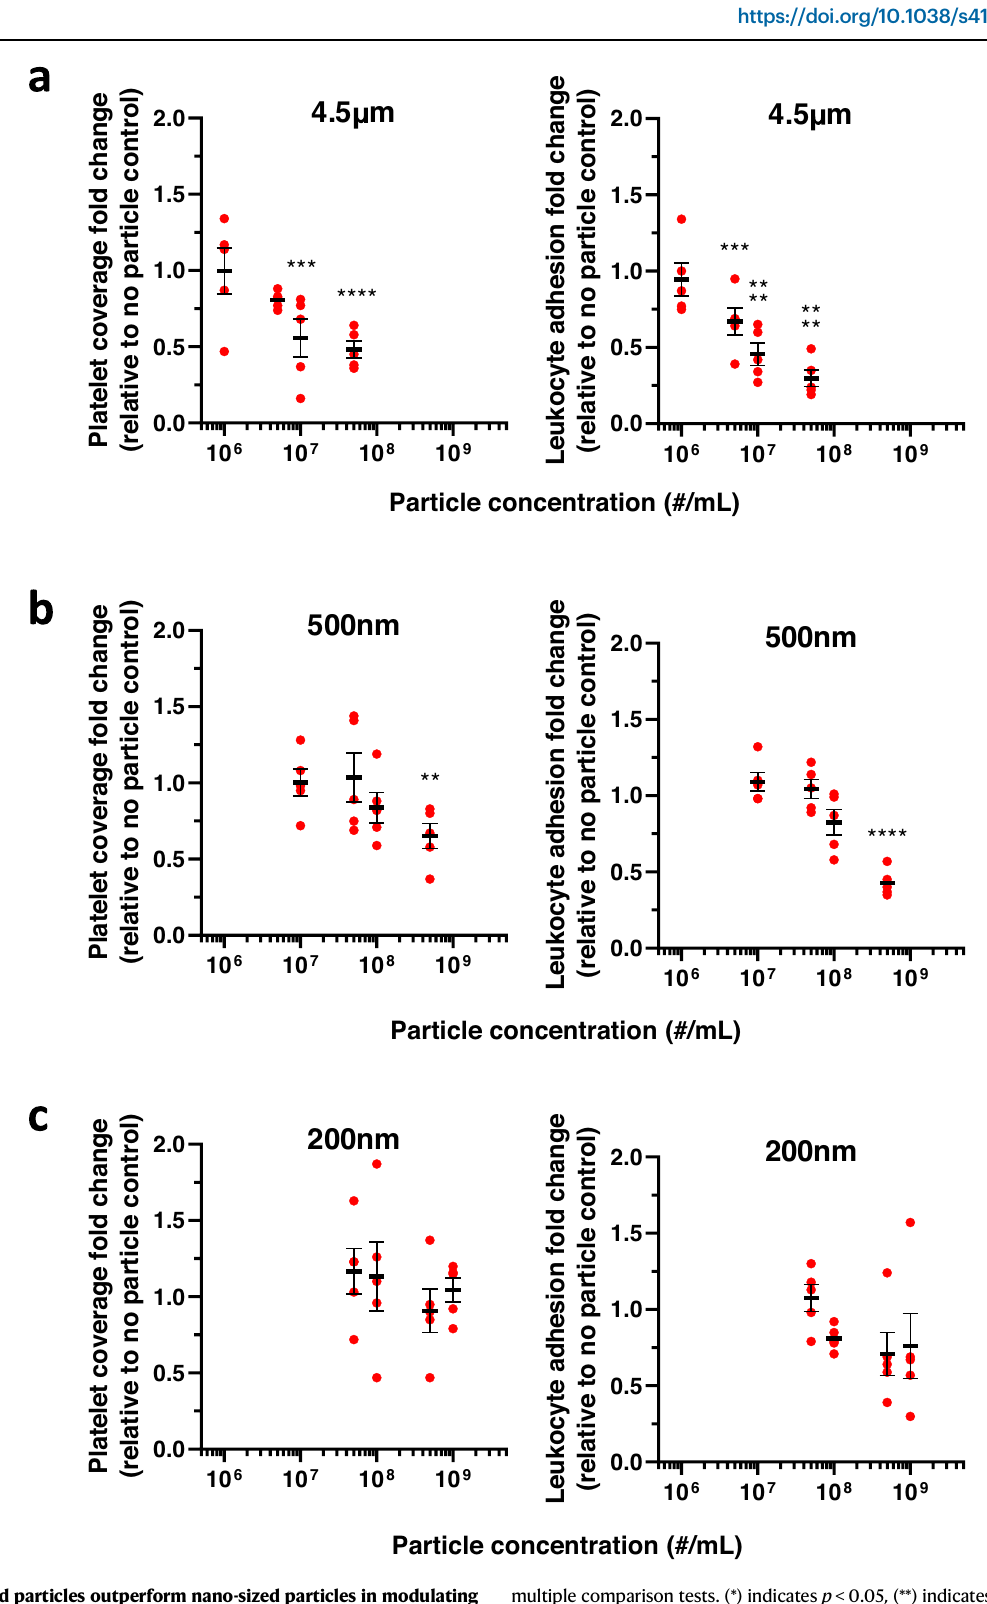
multiple comparison tests. (*) indicates p <0.05, (**) indicates p <0.01, (***) indi- cates p <0.001, and (****) indicates p <0.0001 in comparison to no particle con- trols. Lack of symbols indicates no statistical signi fi cance. Circles represent individual data points, horizontal bar represents the average of individual data points, and error bars represent standard error. Source data and speci fi c p-values are provided as a Source Data fi